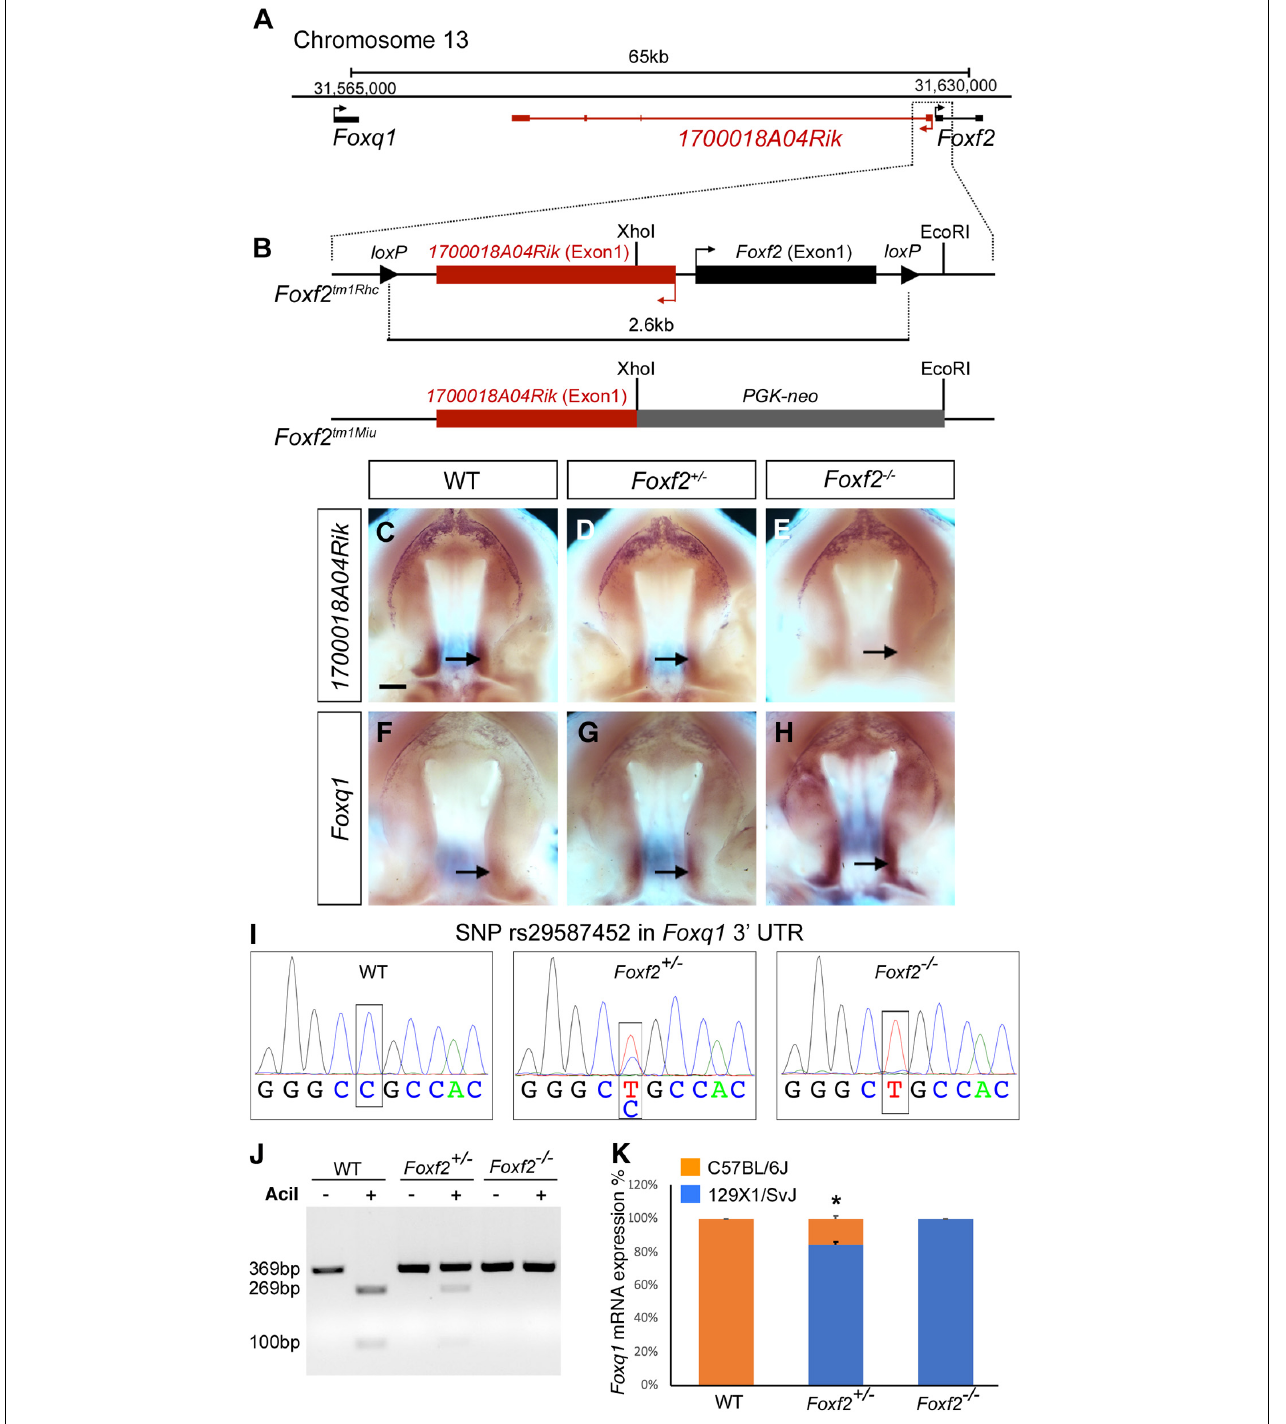
FIGURE 1 | Disruption of Foxf2 causes increased expression of the linked Foxq1 allele in cis in the developing palate. (A) Schematics of the Foxq1 - Foxf2 gene locus. Foxq1 is located 65 kb upstream of Foxf2 , and the two genes are transcribed from the same strand. The lncRNA gene 1700018A04Rik is located between Foxq1 and Foxf2, and is transcribed from the opposite DNA strand. (B) Schematics of the gene targeting strategies of two Foxf2 mutant mouse lines, Foxf2 tm 1 Rhc and Foxf2 tm 1 Miu . Note that both Foxf2 gene-knockout alleles inactivated both Foxf2 and 1700018A04Rik . (C–H) Comparison of patterns of expression of 1700018A04Rik (C–E) and Foxq1 (F–H) mRNAs in the E13.5 wild-type (WT) (C,F), Foxf2 + / − (D,G) , and Foxf2 − / − (E,H) embryos. Note that 1700018A04Rik mRNAs were downregulated, while Foxq1 mRNAs were upregulated along the anterior-posterior axis, and more significantly increased in the posterior (arrows) subdomains